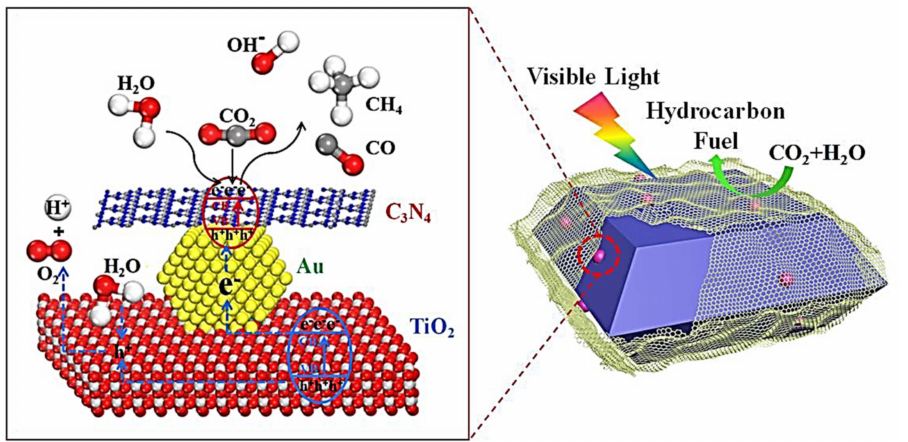
Figure 23. Efficient Z-scheme photocatalysts of ultrathin g-C 3 N 4 -wrapped Au/TiO 2 nanocrystals for enhanced visible-light-driven conversion of CO 2 with H 2 O. Reprinted with permission from Elsevier, 19 December 2021 Ref.